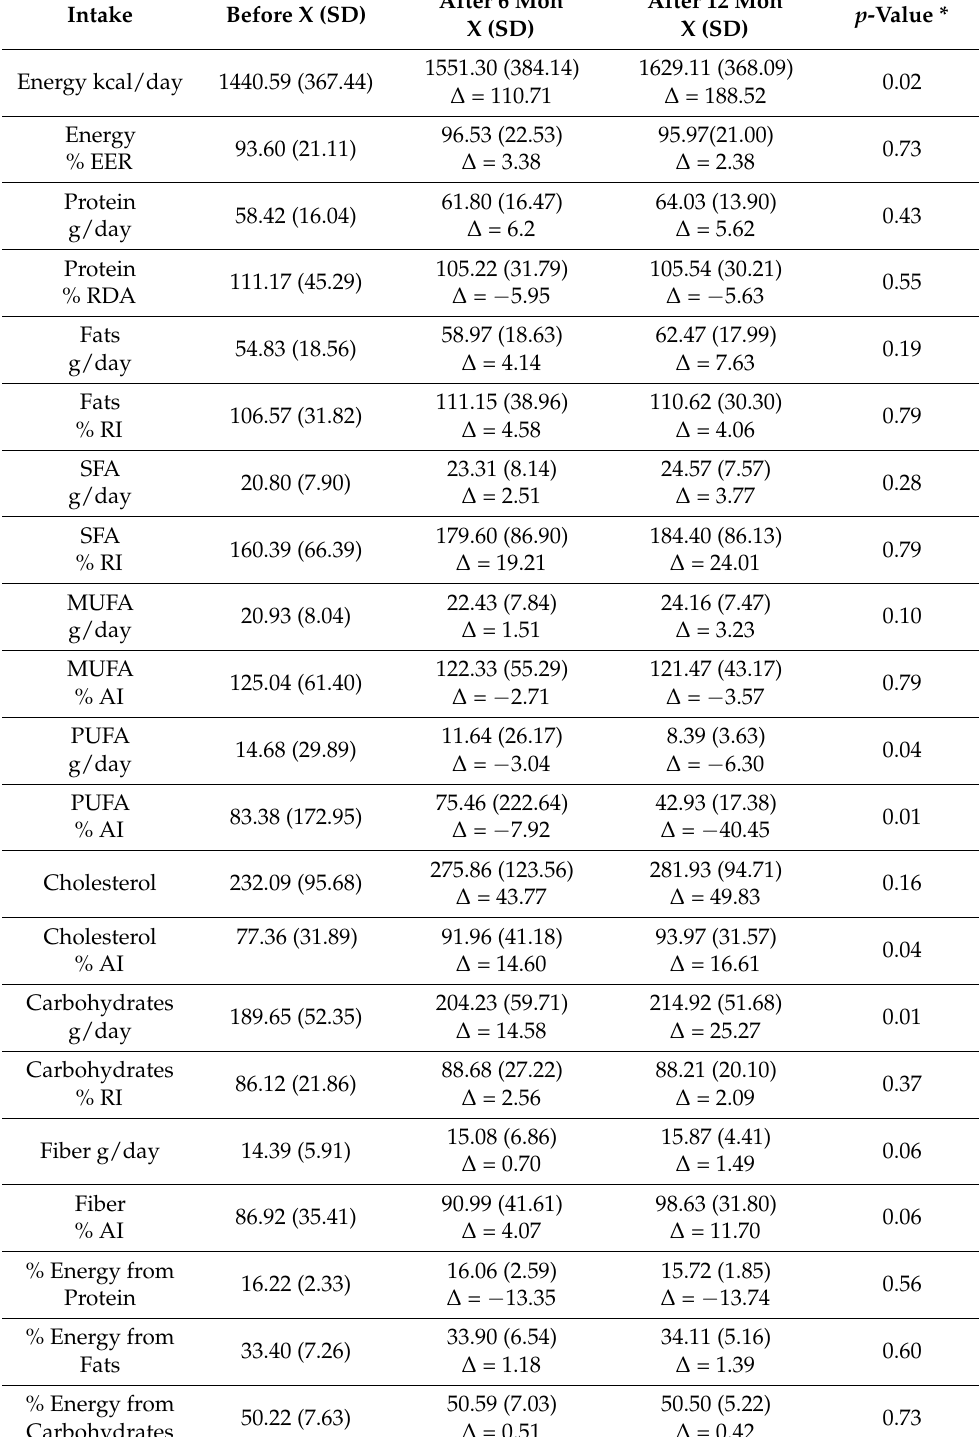
Table 3. Daily dietary intake and norm implementation of energy, macronutrients and fiber in the studied